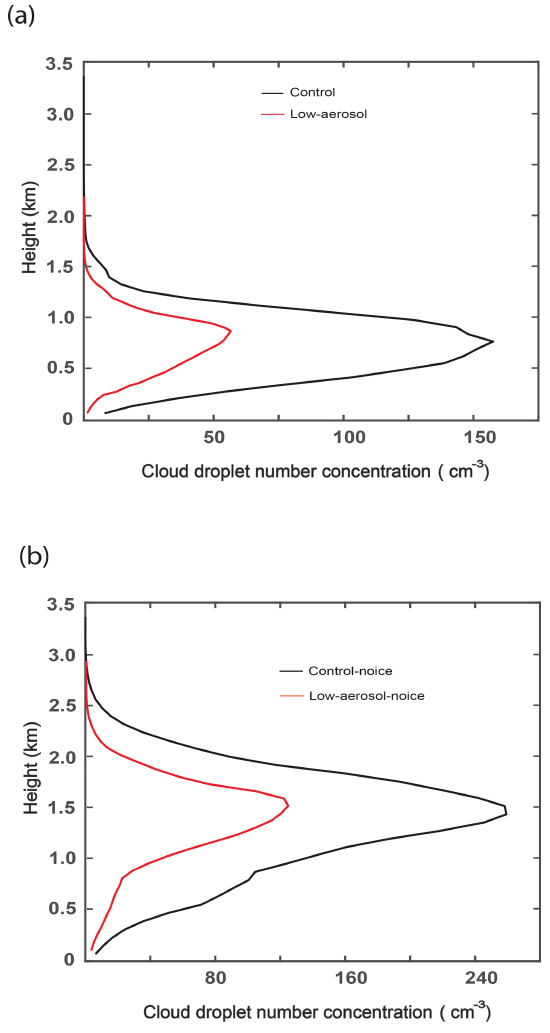
Figure 12. Vertical distributions of the average CDNC over grid points and time steps with non-zero CDNC (for the whole domain and simulation period) (a) in the control and low-aerosol runs and (b) in the control-noice and low-aerosol-noice